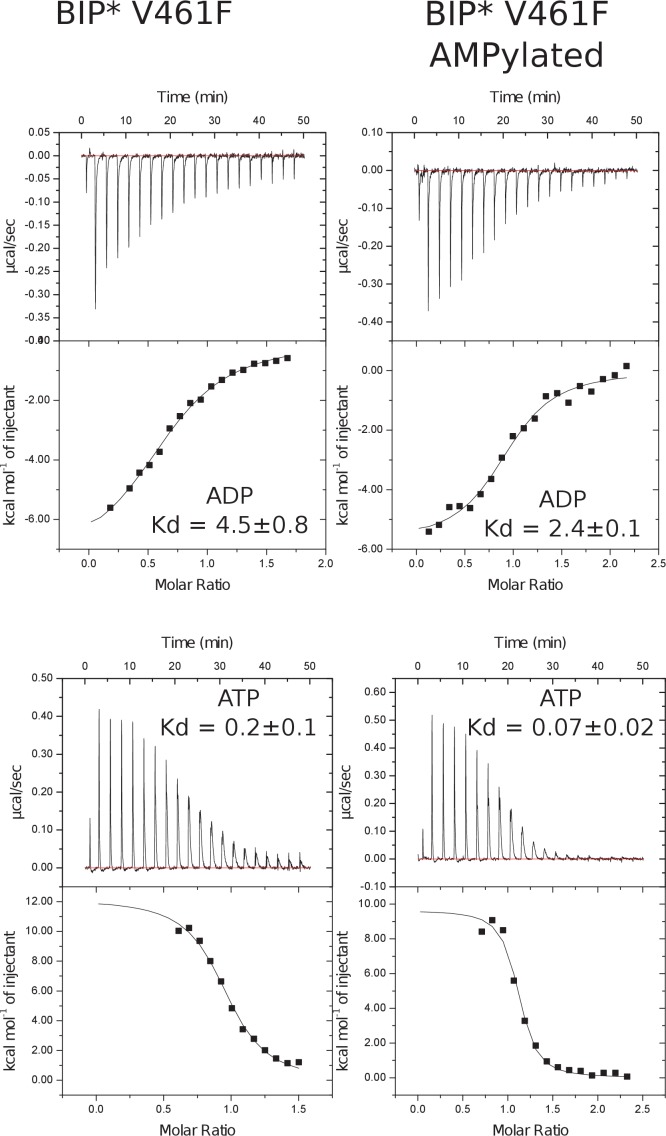
Representative panels showing nucleotide (ATP or ADP) binding to non-AMPylated and AMPylated V461F BiP* measured by ITC. Experiments were performed at 25°C using 30 μM protein in the cell and 0.25–0.35 mM ADP (or ATP) injected from the syringe. Top panels show raw data, and bottom panels show integrated normalized data.